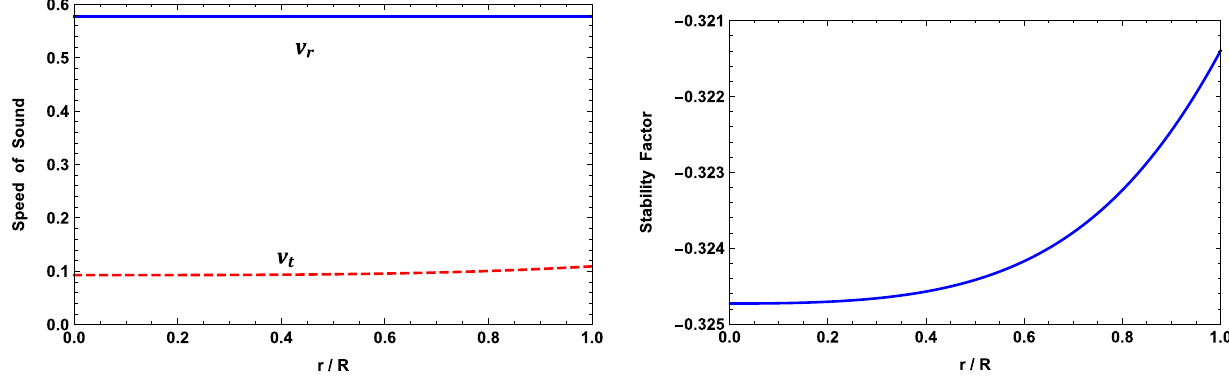
Fig. 5 The speed of sound and stability factor are plotted against r / R by taking the same values as in Fig. 1 for PSR J1903+327